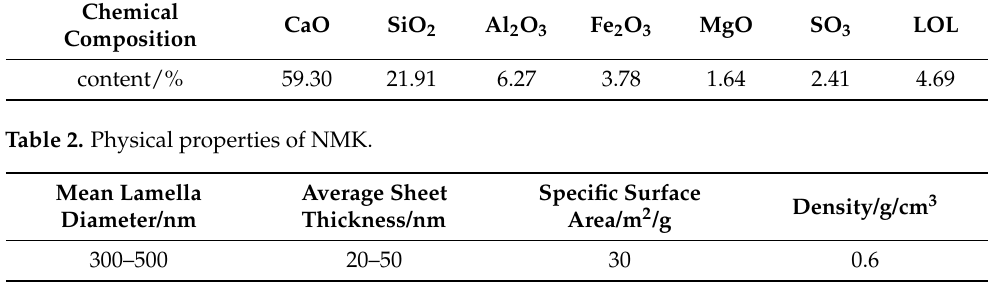
Table 3. Chemical compositions of NMK.